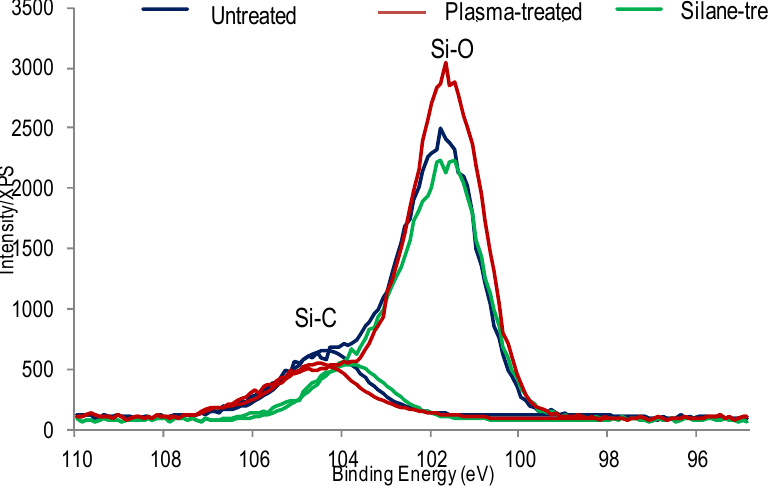
Figure 4. Surface composition of nanoparticles: untreated, silane-treated, and plasma-treated.